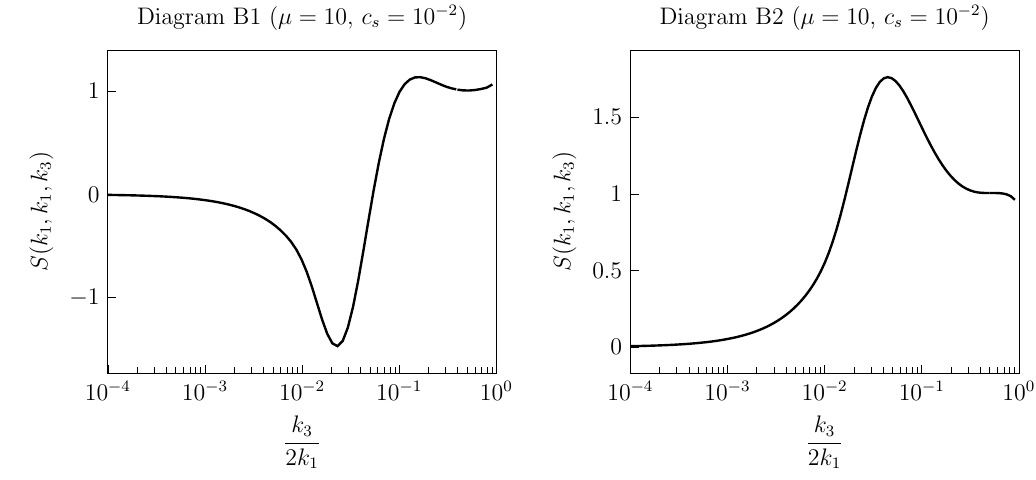
Figure 13 . Shapes S ( k 1 , k 1 , k 3 ) of the bispectra for isosceles triangles, normalized to unity in equilateral configurations, for diagrams B1 (left) and B2 (right) and ( µ = 10 , c